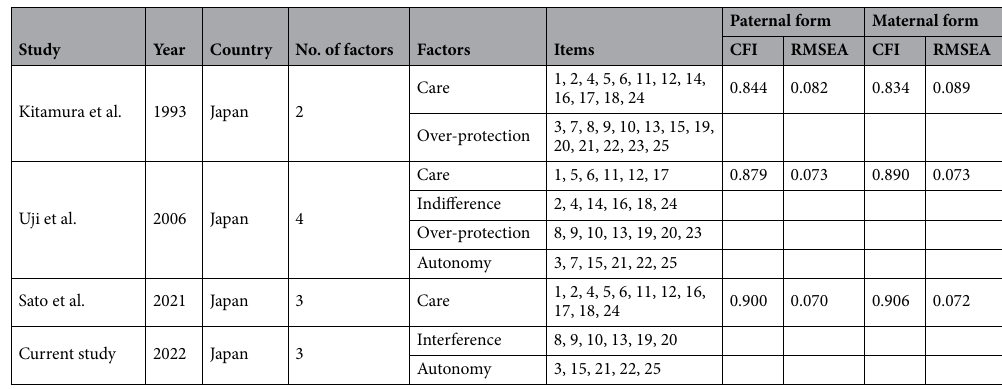
Study Year Country No. of factors Factors Items